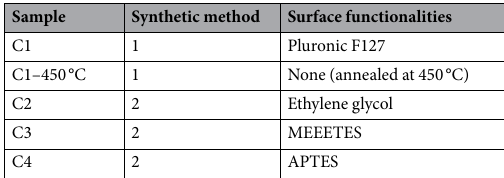
Table 1. CNP samples prepared with method 1: TEMED induced precipitation in the presence of Pluronic F127; and method 2: NH 3 induced precipitation in the presence of EG. TEMED: